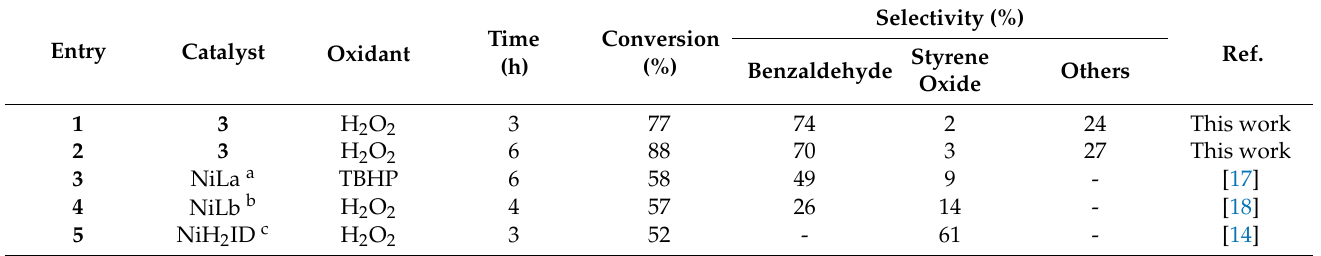
Table 2. Comparison of homogeneous catalytic activities of nickel complexes in the oxidation of